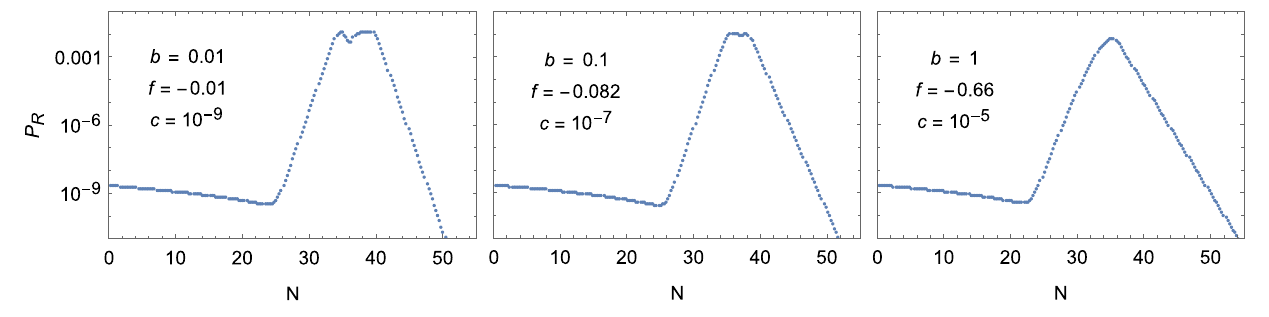
Fig. 5 The power spectra corresponding to the sets of the parameters in Table 2 y becomes non-negligible, the Jordan frame potential U will generically introduce a multifield dynamics involving σ and ρ that eventually settle at their minima, assuming (cid:3) ρ (cid:4) , (cid:3) σ (cid:4) (cid:7)= 0. Next, we study the potential U around the origin σ = ρ = 0, where the second stage of inflation can take place. First we take c = 0, and will later use c (cid:7)= 0 as a small perturbation in order to control the duration of the second stage of